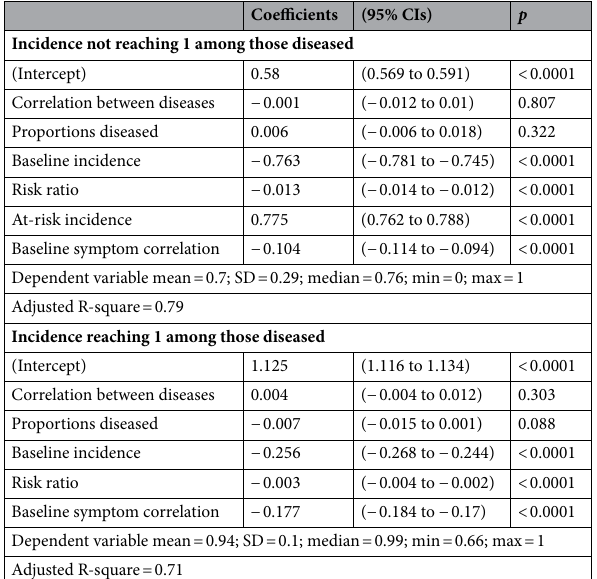
Table 8. Effects of baseline incidence, proportions diseased, risk ratios, and baseline symptom correlations on the maximal area under the receiver operating characteristic curve using at most 40 symptoms for disease diagnosis. CI confidence interval, SD standard